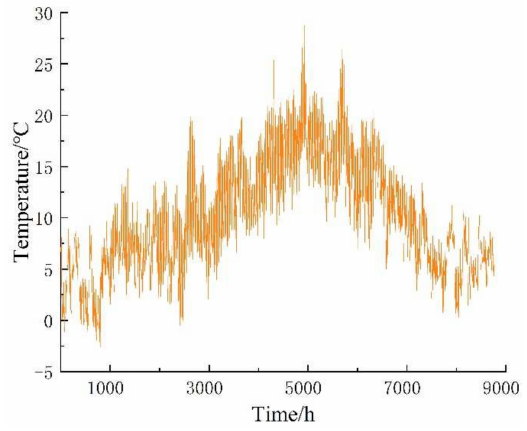
Figure 8. Full year temperature forecast curve.